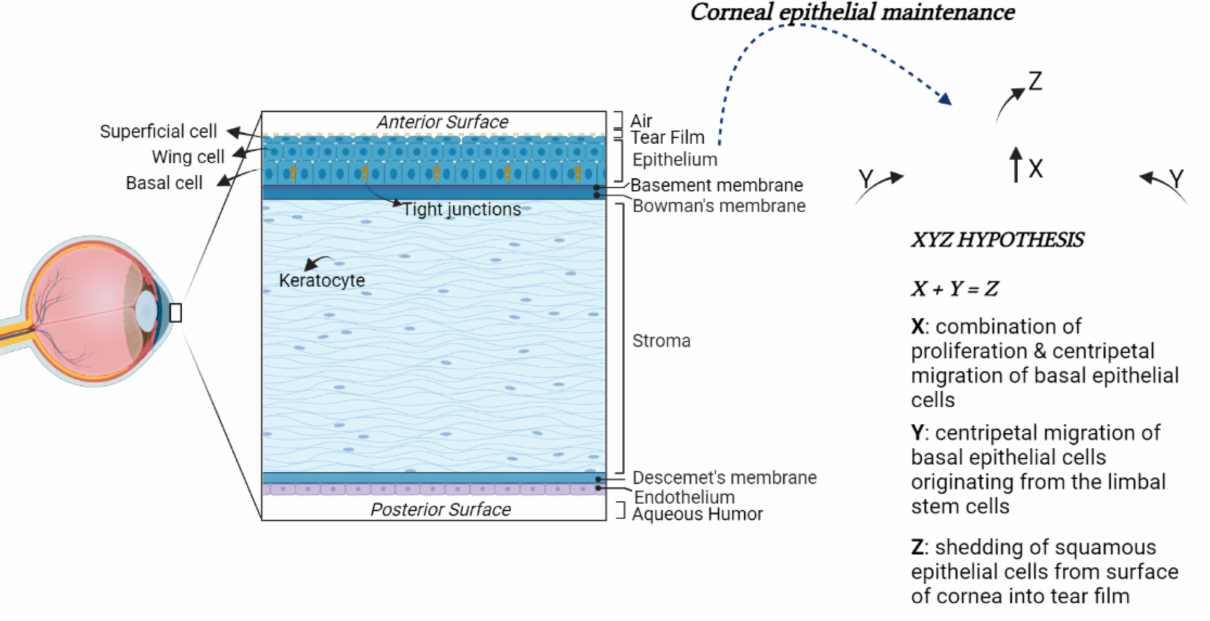
Figure 1. Structural anatomy of the human cornea. From left to right: (1) A diagram of human cornea structure; (2) The XYZ hypothesis. The asymmetric division of LESCs generates a stem-like daughter cell, remaining within the limbus, and a TAC, migrating in a centripetal direction (Y). TACs undergo multiple replications. In this process, they lose stemness, migrate anteriorly and differentiate to post-mitotic suprabasal wing cells (X), and progress in superficial squamous cells, which are lost during normal corneal surface exfoliation (Z) of the epithelial corneal